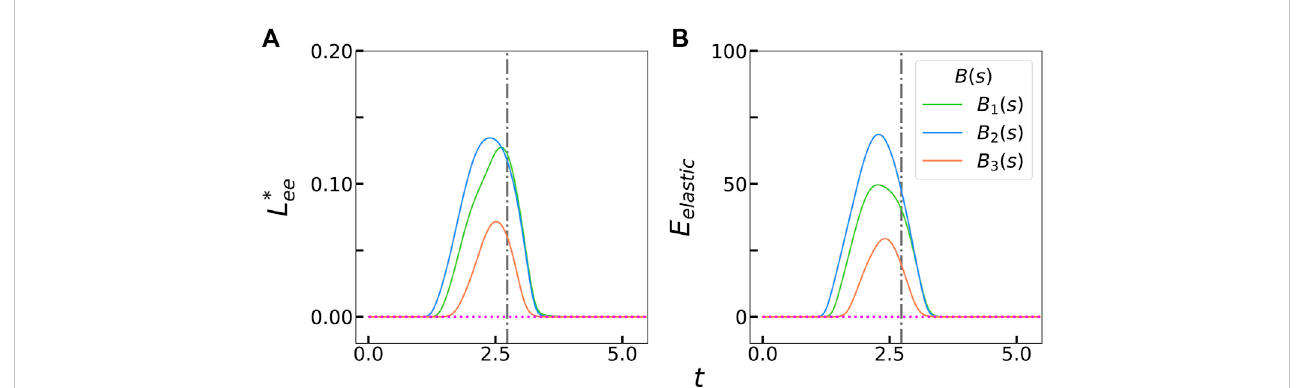
FIGURE 3 (A) Measured fi lament compression L ee * and (B) elastic energy for the duration of the simulation of the three stiffness pro fi les in Figure 2. The magenta dottedlineineachpanel representsarigid,unperturbed fi lament.Thegraydash-dotvertical linerepresentsthetimeatwhicharigid fi lamentisorientedat θ = π /2 relative to the horizontal.